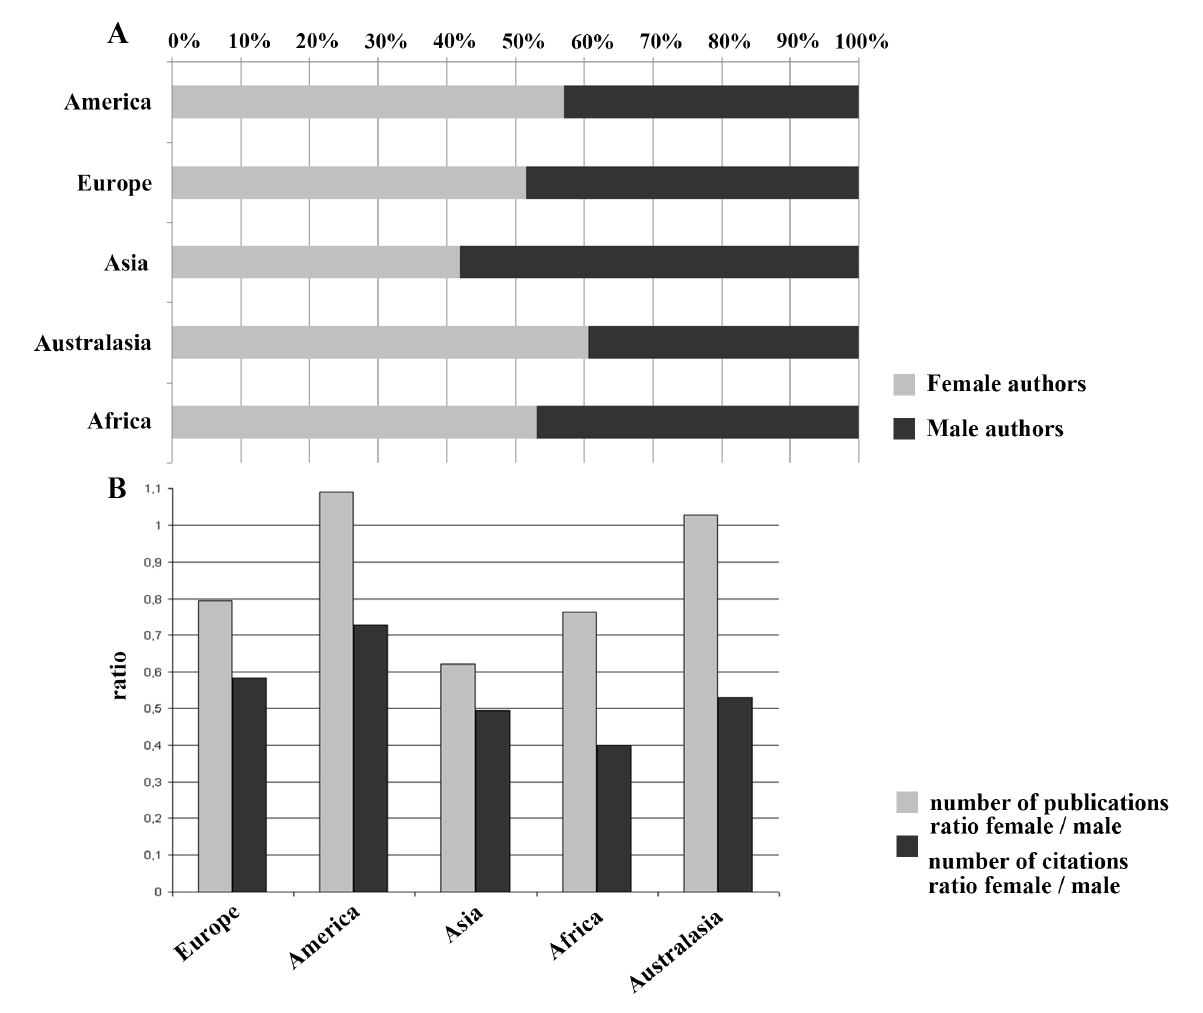
Figure 5. Regional gender analyses. ( A ) Proportion of the number of female and male authors according to continents; ( B ) Female/male publication ratios and female/male citation